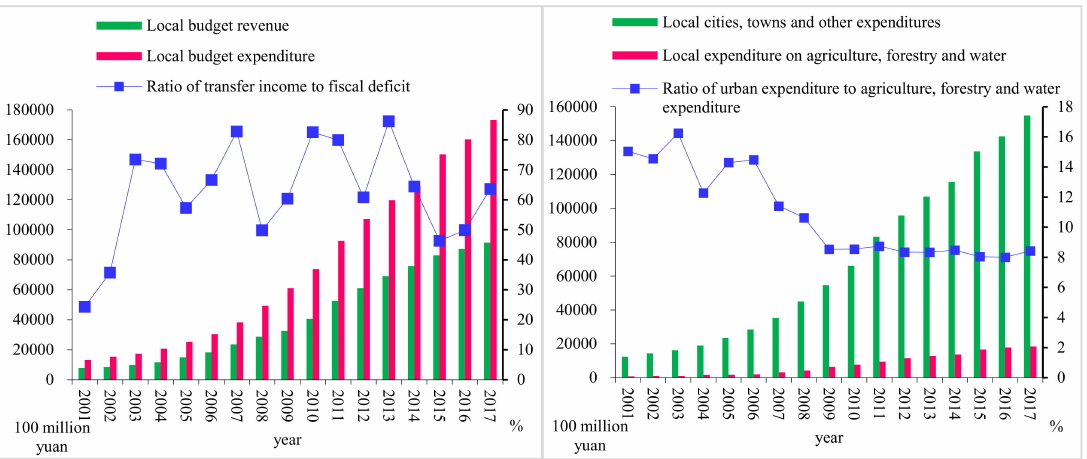
Figure 2. Proportion of land transfer income to fiscal deficit and scale and proportion of local finance expenditure on cities and towns, agriculture, forestry, and